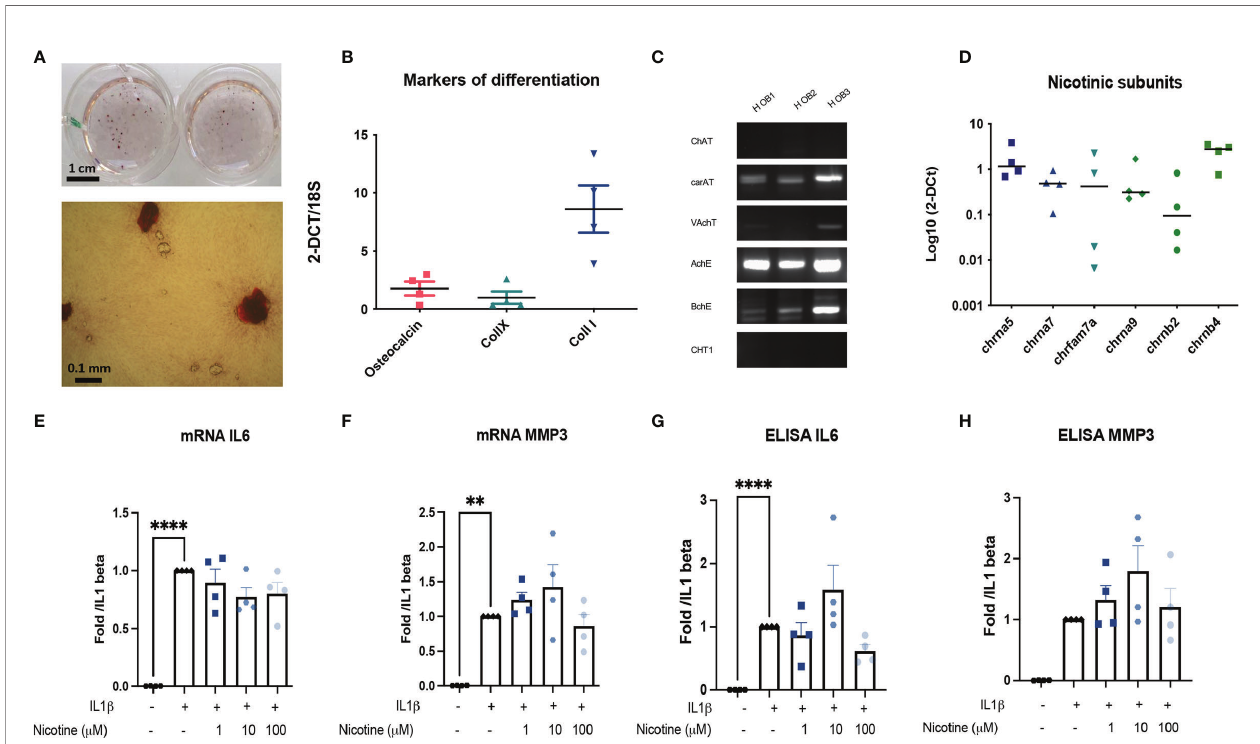
FIGURE 4 | Primary human outgrowth OA OB belongs to the non-neuronal cholinergic system. (A) Representative calci fi cation of extracellular matrix of Human OB using red alizarin staining. (B) Relative mRNA expression of osteocalcin, collagen type X (collX), and collagen type I (Coll I) of Human OB. (C) Representative RT-PCR analysis of the cholinergic system expressed by Human OB ( n = 3). (D) qPCR expression of nAchR subunits ( n = 4). (E) mRNA IL6, (F) MMP3 and ELISA, (G) IL6, and (H) MMP3 expression by Human OB pretreated with 1, 10, or 100 µM nicotine for 15 min and stimulated with 10 ng/ml IL1 b for 24 h ( n = 4, ** p < 0.01, **** p < 0.001 using RM one-way ANOVA with Dunnett post-test). The results are normalized to the IL1 b condition. ChAT, choline acetyltransferase; carAT, carnityl acetyltransferase; VAChT, vesicular acetylcholine transporter; AChE, acetylcholine esterase; BChE,